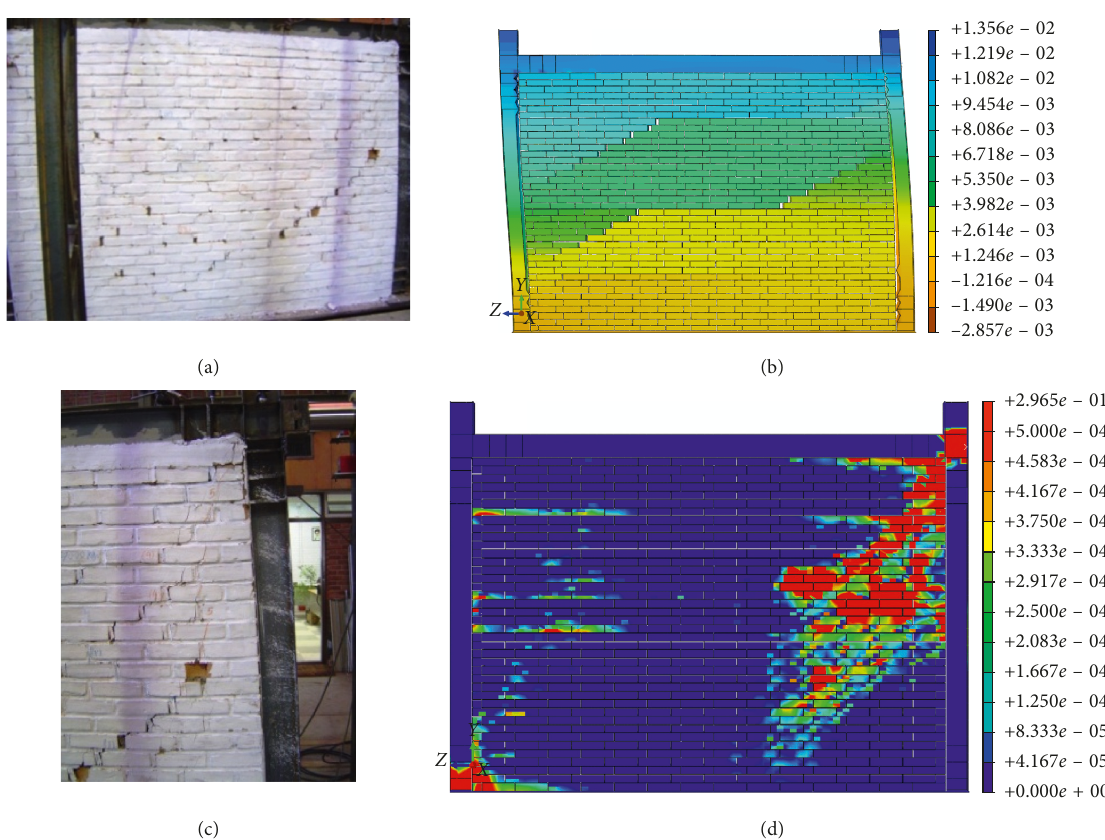
Figure 6: Comparison of the results between the experimental specimen and the numerical model. (a) Failure mode of the experimental specimen [24]. (b) Failure mode of the numerical model. (c) Crushing of bricks in the experimental specimen [24]. (d) Crushing of bricks in the numerical